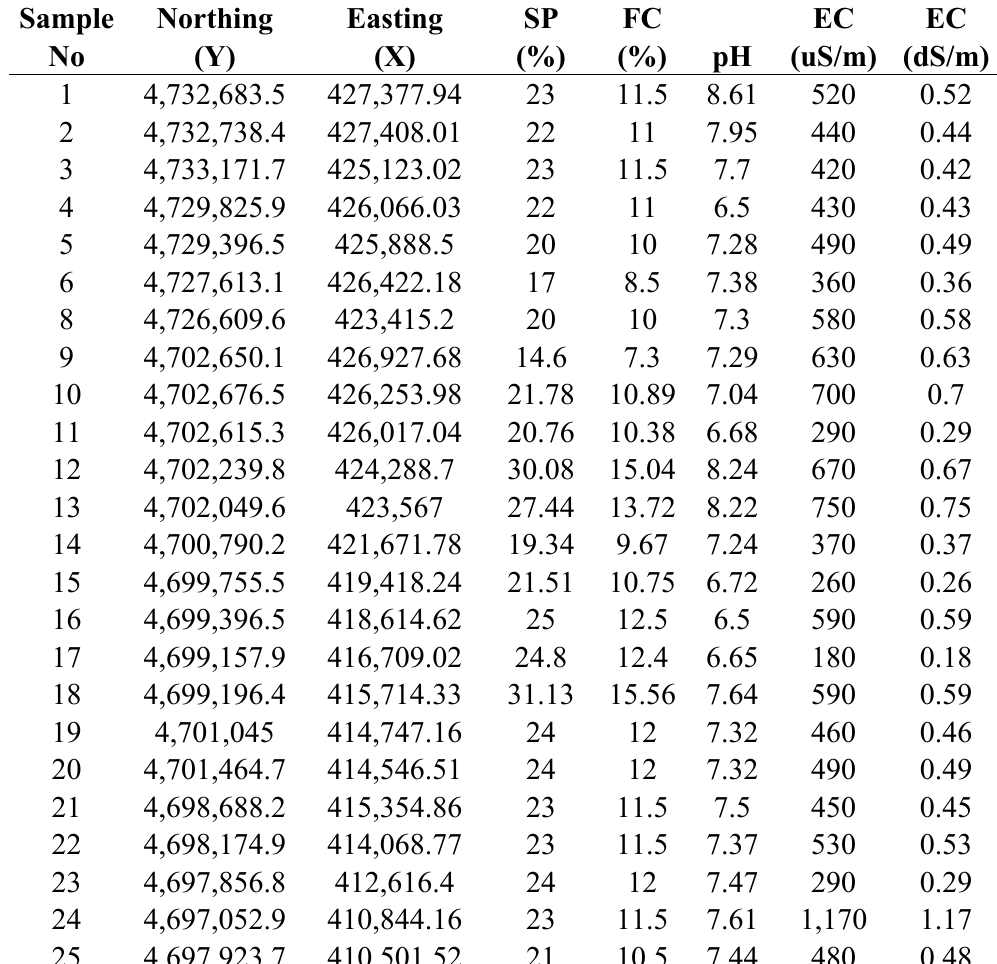
Table 3 . Soil samples and their XY coordinates, saturation percentage (SP), field capacity (FC), pH and EC